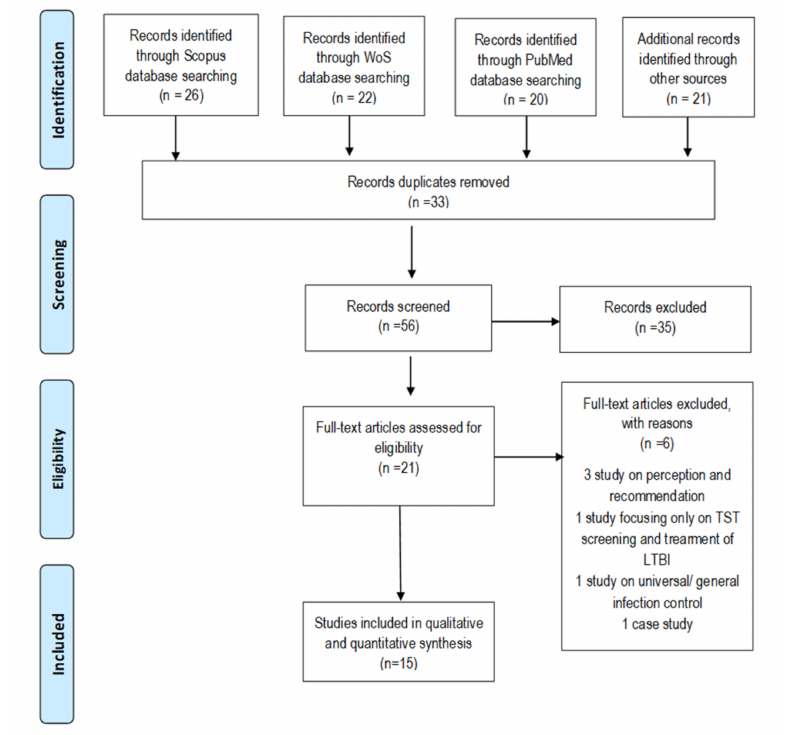
Figure 1. PRISMA flow